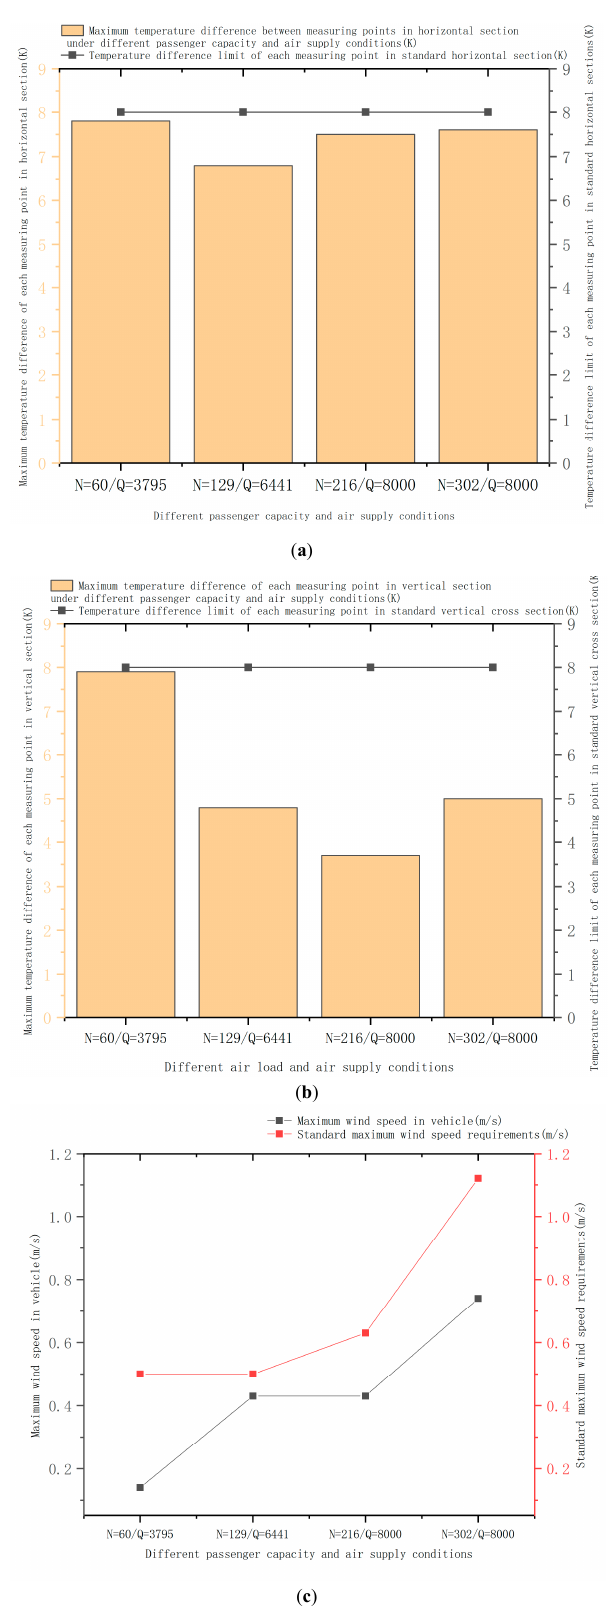
Figure 9. In-vehicle temperature field and velocity field data. There is a maximum temperature difference between each measurement point in the horizontal section ( a ), a maximum temperature difference between each measurement point in the vertical section ( b ) and a maximum wind speed in the vehicle ( c ).